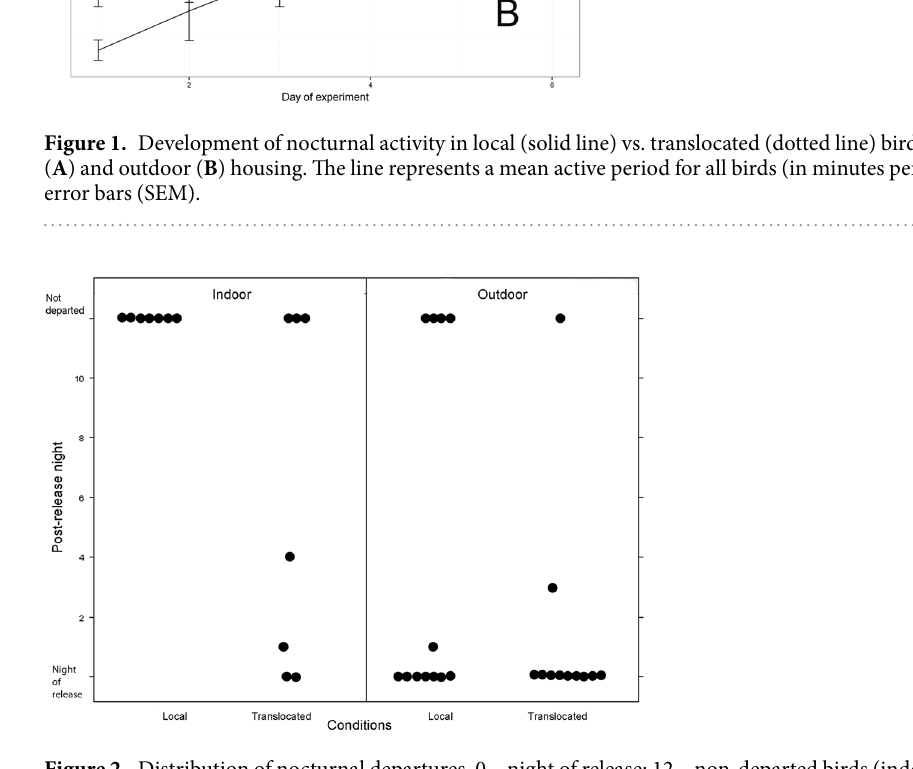
Figure 2. Distribution of nocturnal departures. 0 – night of release; 12 – non-departed birds (indoor – left panel, outdoor – right